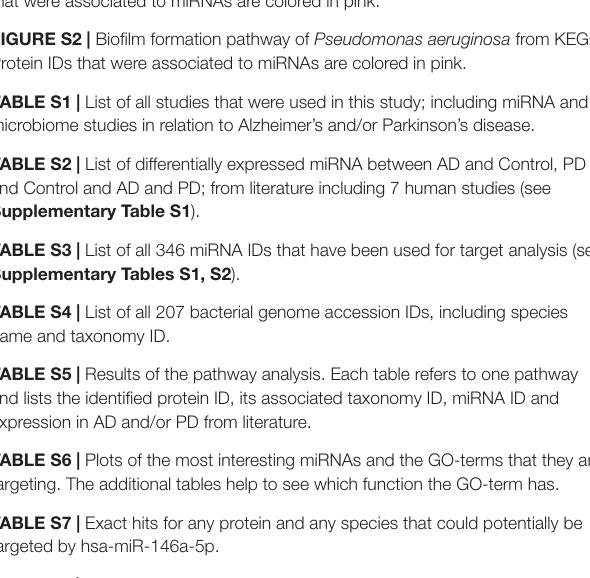
TABLE S5 | Results of the pathway analysis. Each table refers to one pathway and lists the identified protein ID, its associated taxonomy ID, miRNA ID and expression in AD and/or PD from